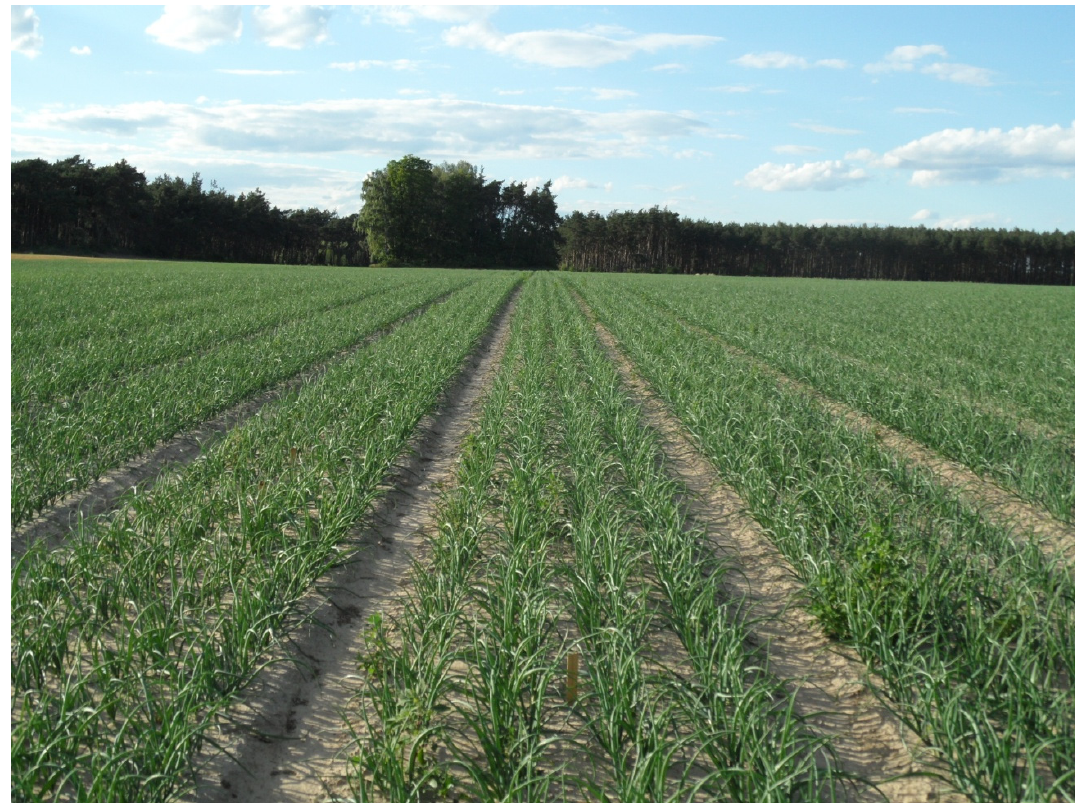
Figure 1. Row-band system of onion cultivation using the parallel steering system.